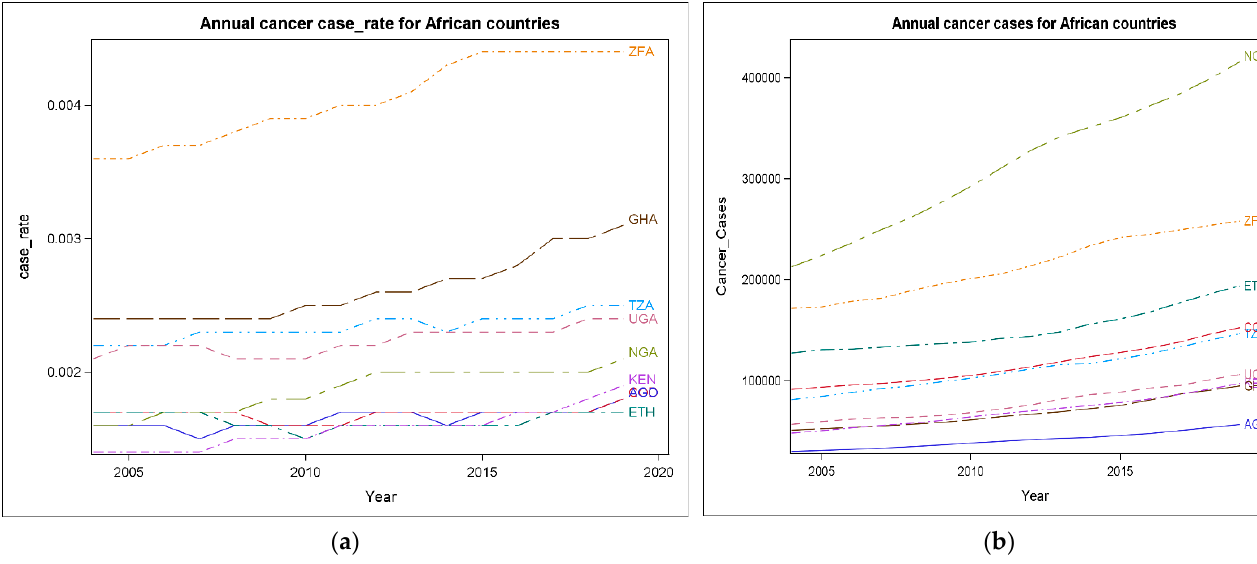
Figure 3. ( a ) Cancer case rate trends during 2005–2020; ( b ) cancer case trends during